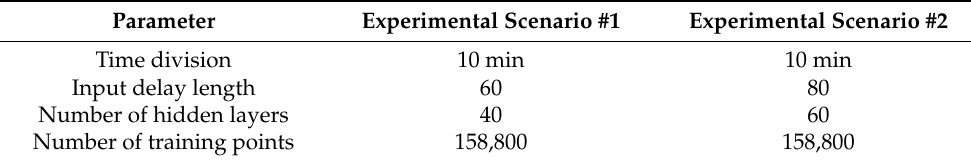
Table 11. Network parameters used to evaluate the impact of added noise.